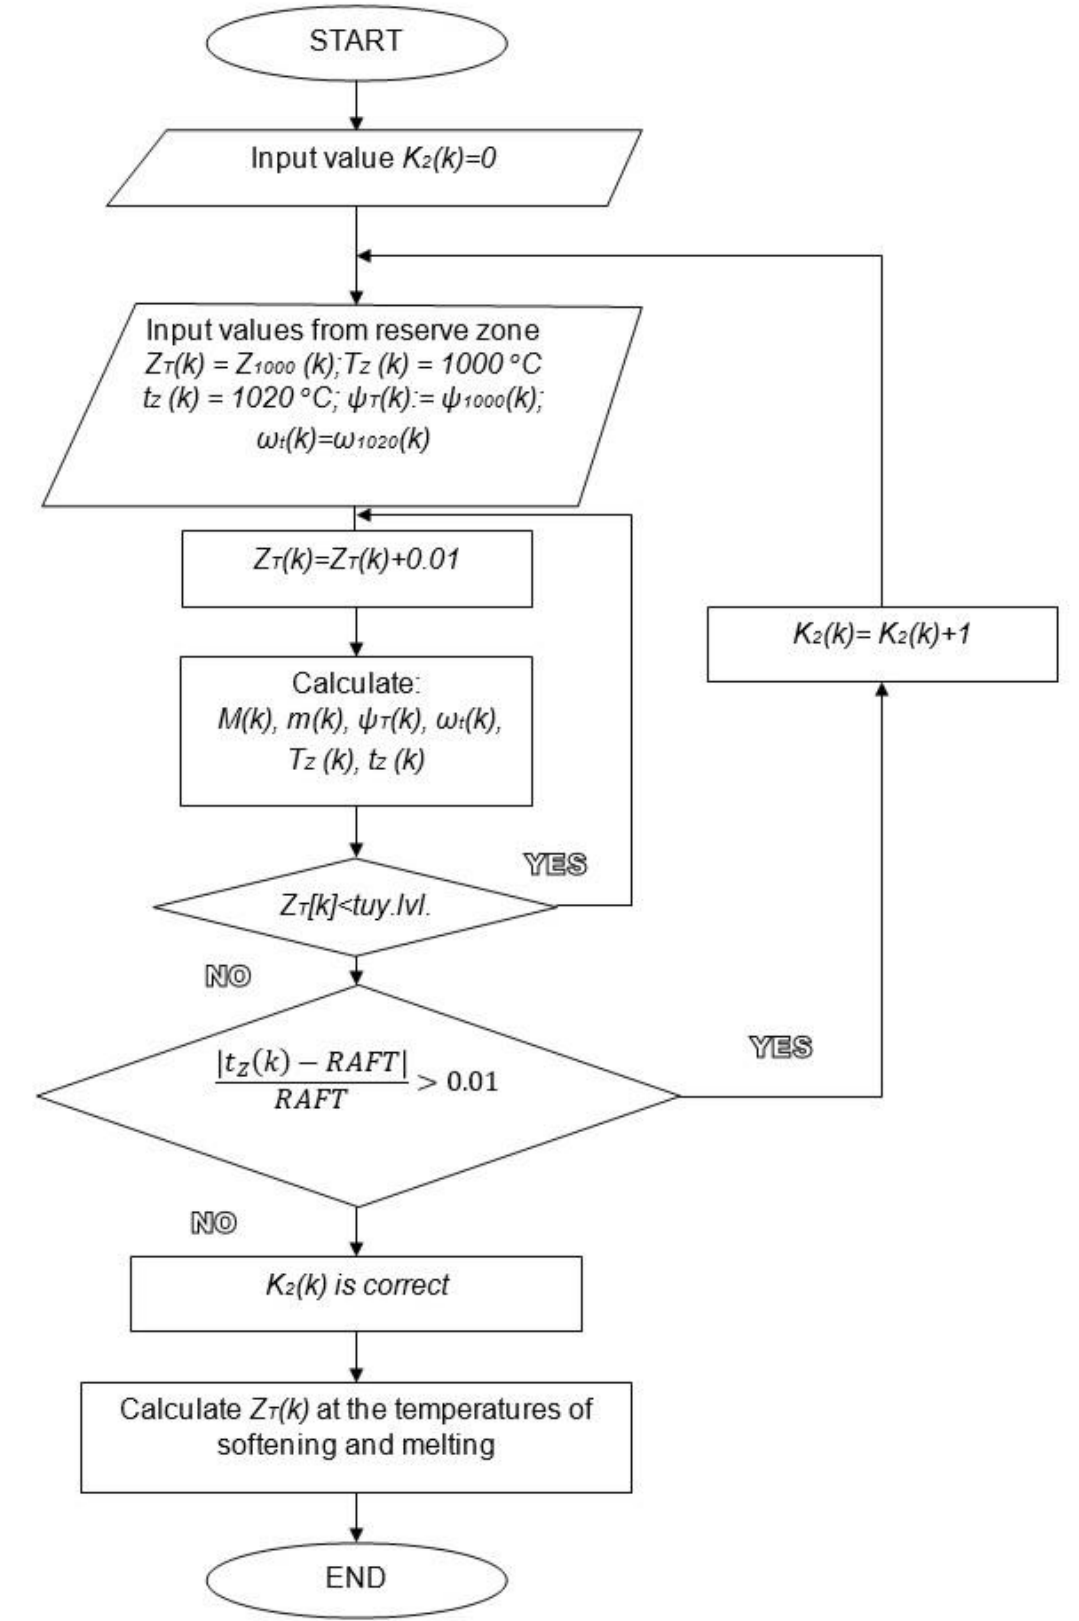
Figure 5. Algorithm of softening and melting isotherm levels calculations for each segment.